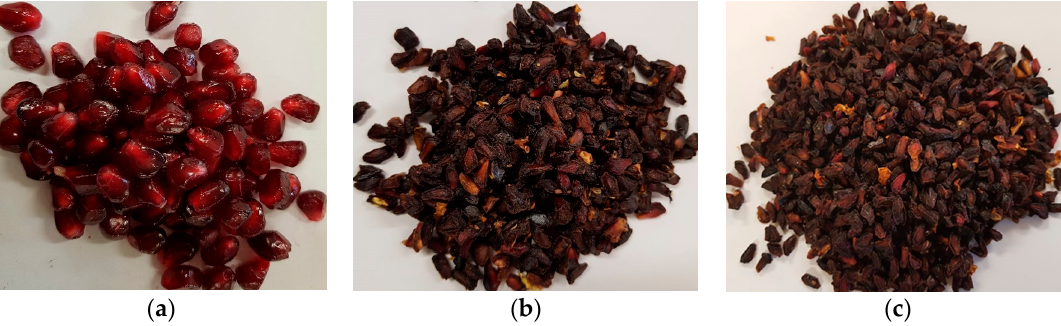
Figure 2. Pomegranate arils at different stages ( a ) samples before processing, ( b ) blanch-assisted dried arils and ( c ) unblanched dried arils (control).